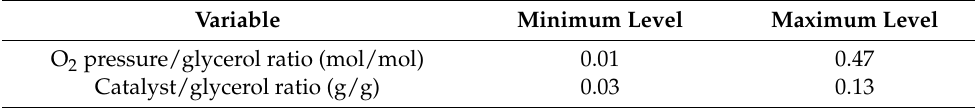
Table 6. Variables considered in CCD 2.